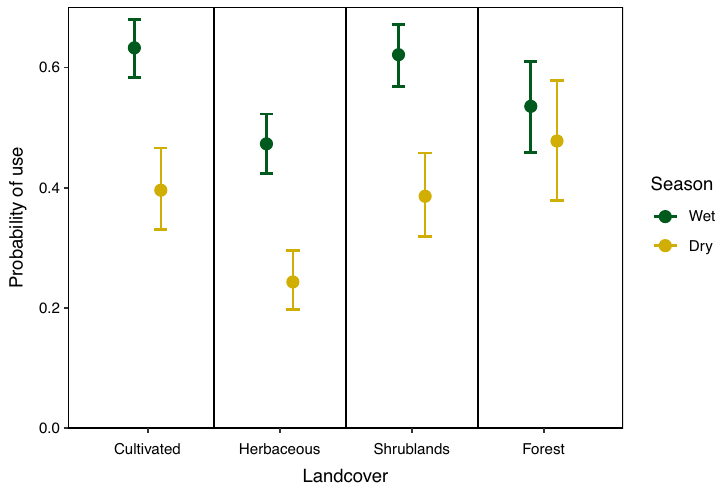
Figure 5. Lion probability of use and 95% confidence intervals in cultivated lands, herbaceous vegetation, shrublands, and forest during wet (November–May) and dry (June–October) seasons, holding other continuous variables at mean values and using categorical variables of female sex, northern area, and core protection, Serengeti ecosystem, Tanzania,